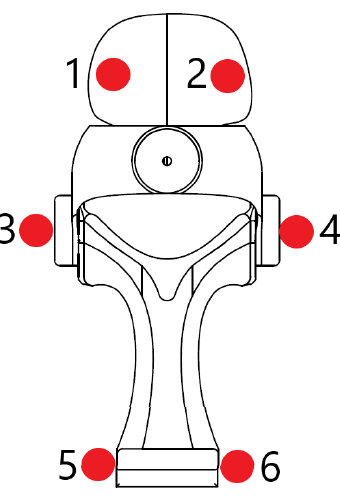
Figure 2. Marker locations for wearable device analysis. Markers 1 and 2 approximate the anatomical positions of the second and fifth metacarpophalangeal markers, markers 3 and 4 approximate the positions of the radial and ulnar styloid markers, and markers 5 and 6 approximate the anatomical positions of the medial and lateral humeral epicondyle